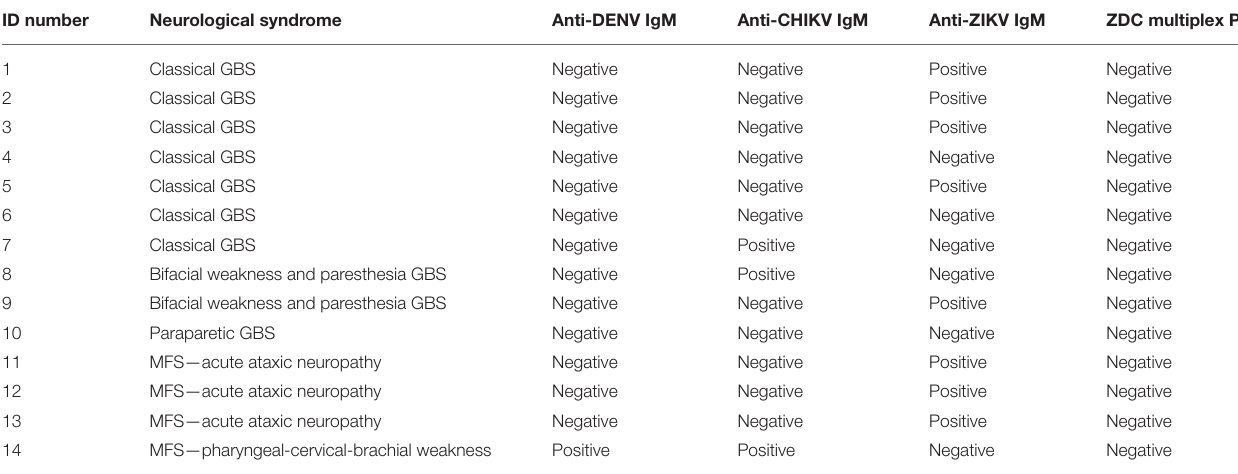
TABLE 3 | Neurological syndrome and arbovirus diagnosis profiles in 14 patients with GBS or its subtypes; Salvador, Brazil, 2015–2016. ID